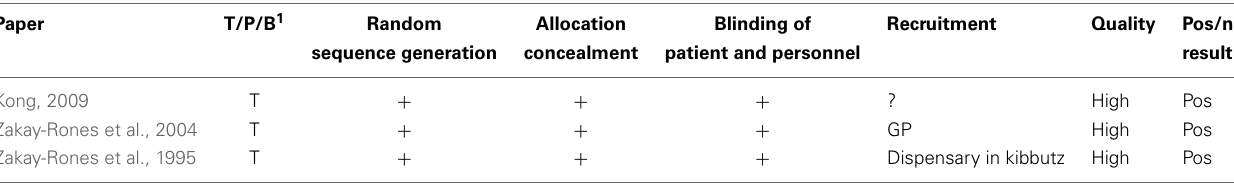
Table 5 | Quality of the studies of efficacy of Sambucus nigra